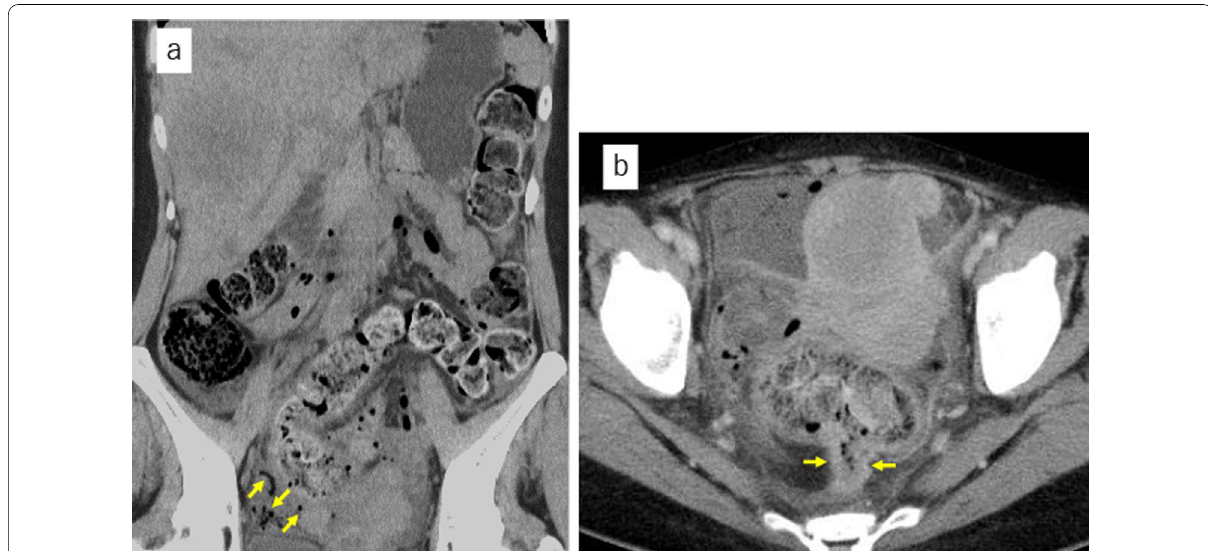
Fig. 1 Computed tomography in Case 1. a Computed tomography showed a large amount of fecal mass in the colon and free air (yellow arrows) in the pelvis. A large mass was observed in the liver. b There was wall thickening in the rectum (yellow arrows), and the oral side of the rectum was dilated and had a fecal mass. Multiple uterine fibroids were seen, and ascites with free air was observed around